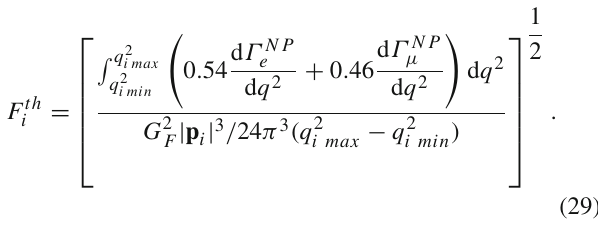
Fig. 6 Allowed regions (cyan) of ( a ) λ LL curves are excluded at 95%